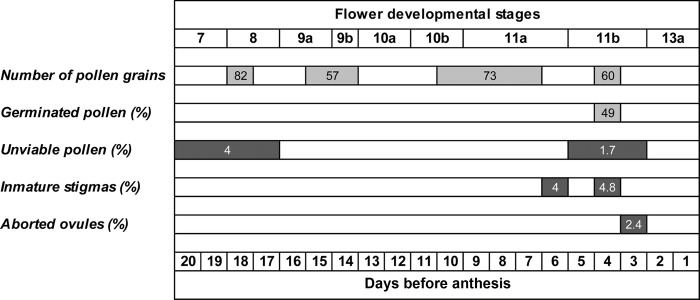
Low-temperature critical periods (grey bands) in days before anthesis of strawberry flower development, detected after subjecting flowers buds at different developmental stages to chilling (24 h at 2 °C). Periods were identified when strawberry flowers at stage 13a displayed significant (P < 0.05; n = 5–10) differences between the cold and control treatments in any of the following variables: number of pollen grains, percentage of germinated pollen, percentage of unviable pollen, percentage of immature stigmas and percentage of aborted ovules. The n-fold increase or the decrease percentages for each variable are depicted in the dark grey bands and light grey bands, respectively.